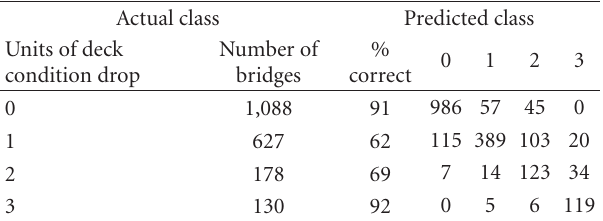
Table 5: Degree of success in deck condition deterioration prediction using the general classification tree.